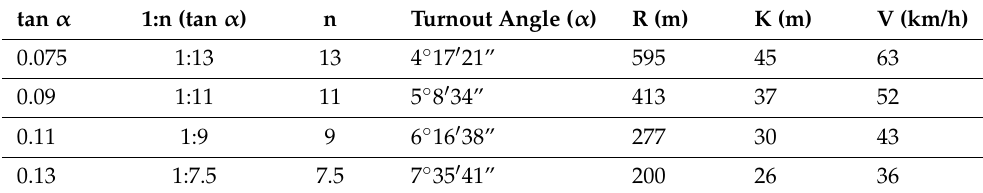
Figure 9. Scheme and calculations . F c cos β = P sin β